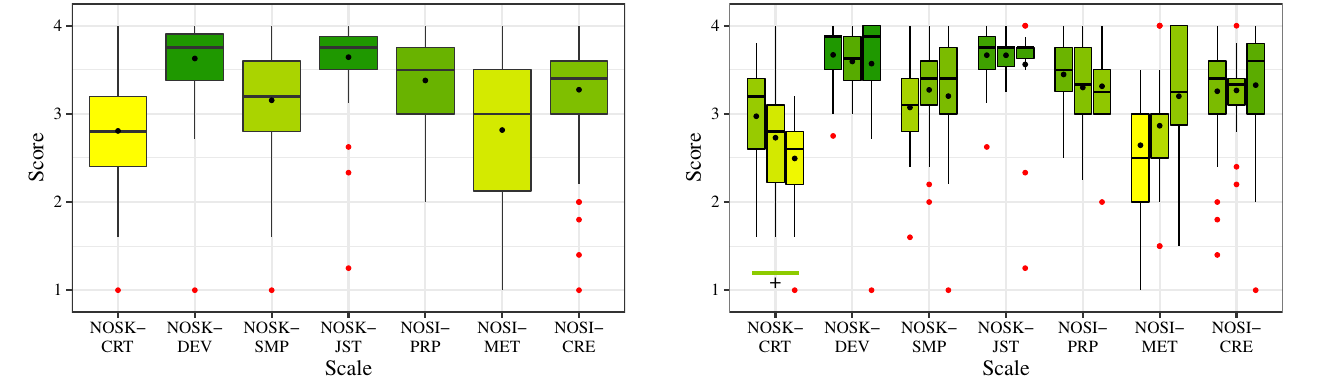
FIG. 1. Adequateness of students ’ beliefs. Higher scores indicate more appropriate beliefs in the respective areas. Hori- zontal bars indicate scale medians, black dots indicate arithmetic means, red dots represent outliers. Raw numbers can be found in Table IV.